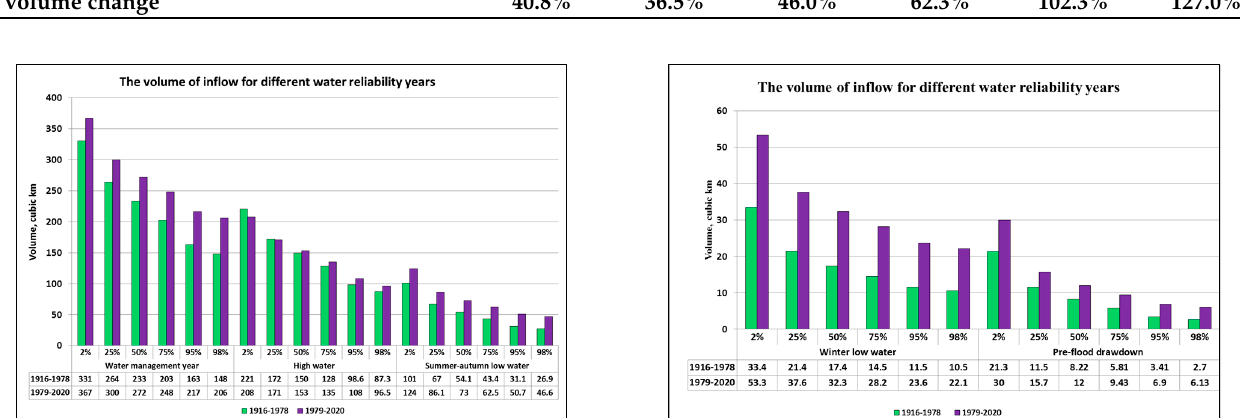
Figure 9. Reliability graphs of in fl ow reliability for two long-time series and di ff erent seasons.